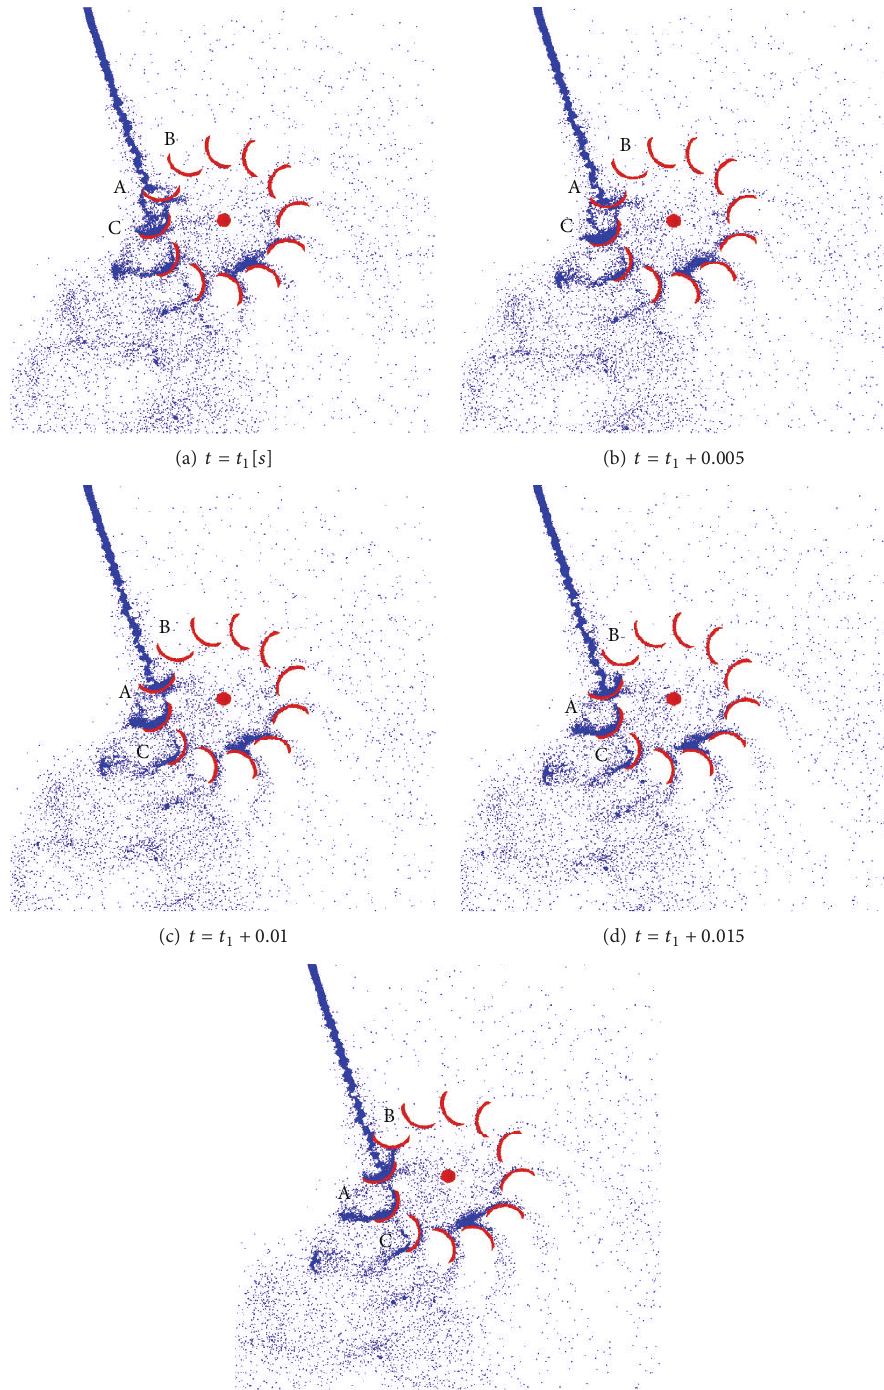
Figure 4: Time variation for particle distribution when 𝜆 = 0.56